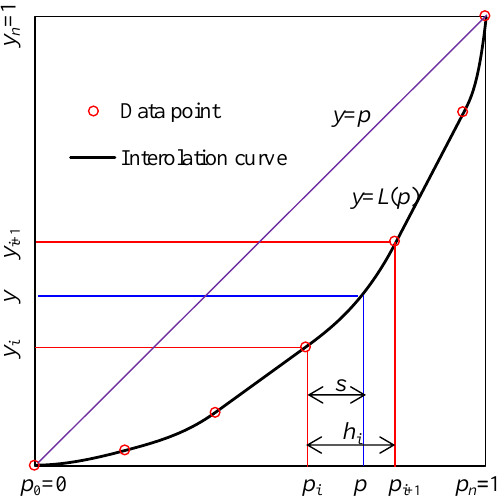
Figure 2. Sketch of data points and interpolated Lorenz curve.